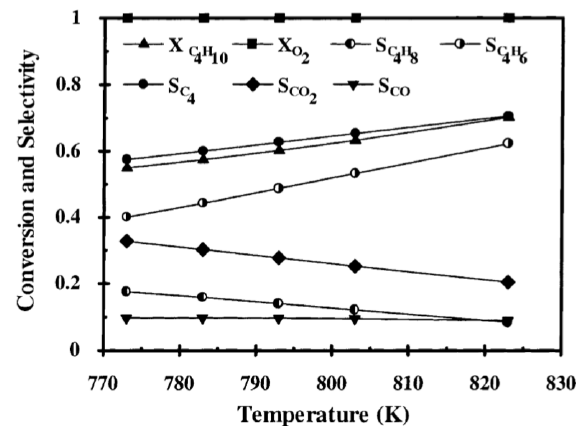
Figure 12. The effect of the reaction temperature in the FBR. ODH reaction on V/MgO was studied by mathematical modeling of a FBR. According to the results of the study, the selectivity to C 4 increased with the increasing temperature. (Reprinted with permission from [56]. Copyright 2002